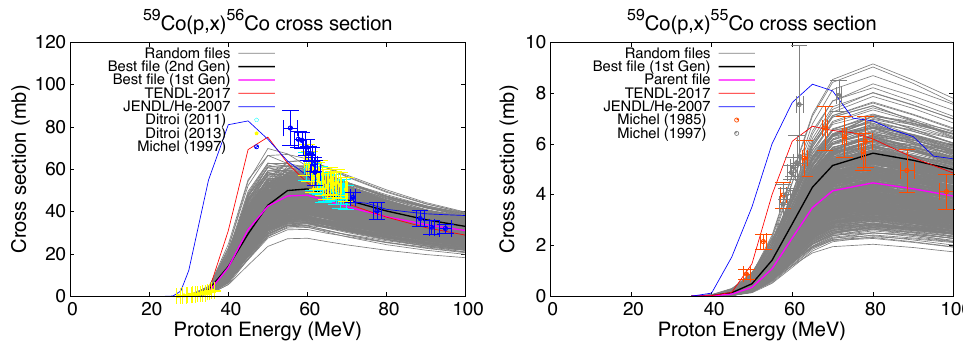
Figure 3. Comparison of file performance between our evaluation and the TENDL-2017 evaluation as well as the JENDL / He-2007 for the 59 Co(p,x) 56 Co and 59 Co(p,x) 55 Co residual production cross